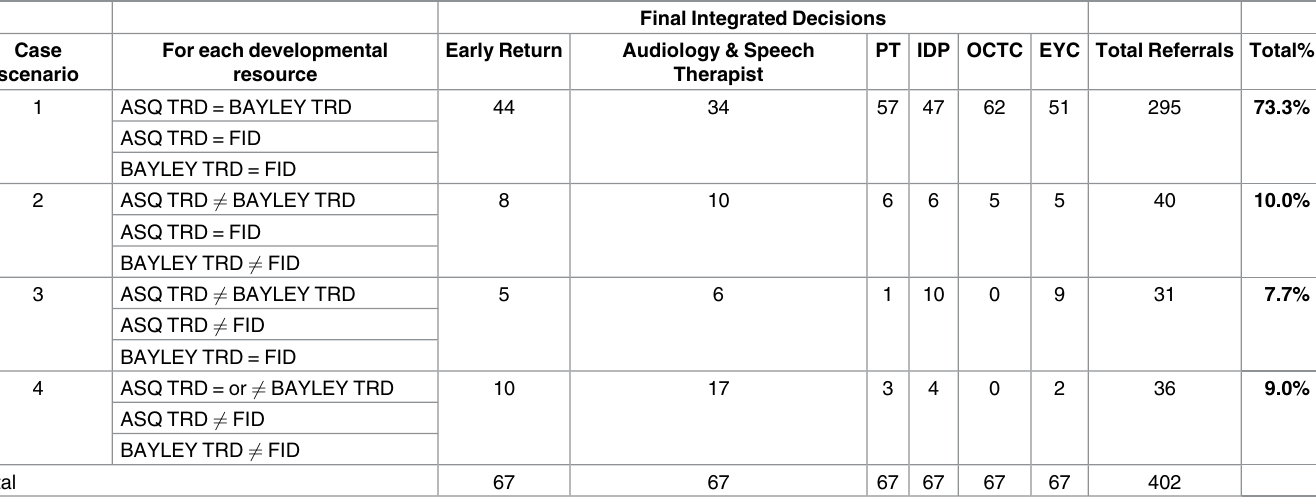
Table 3. Utility of the assessmenttools according to case-scenario.